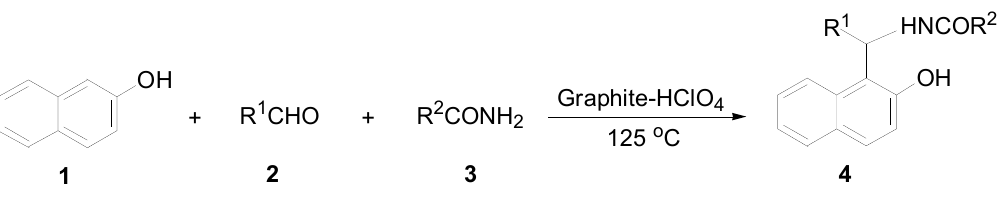
-C under different conditions for the reaction of 4